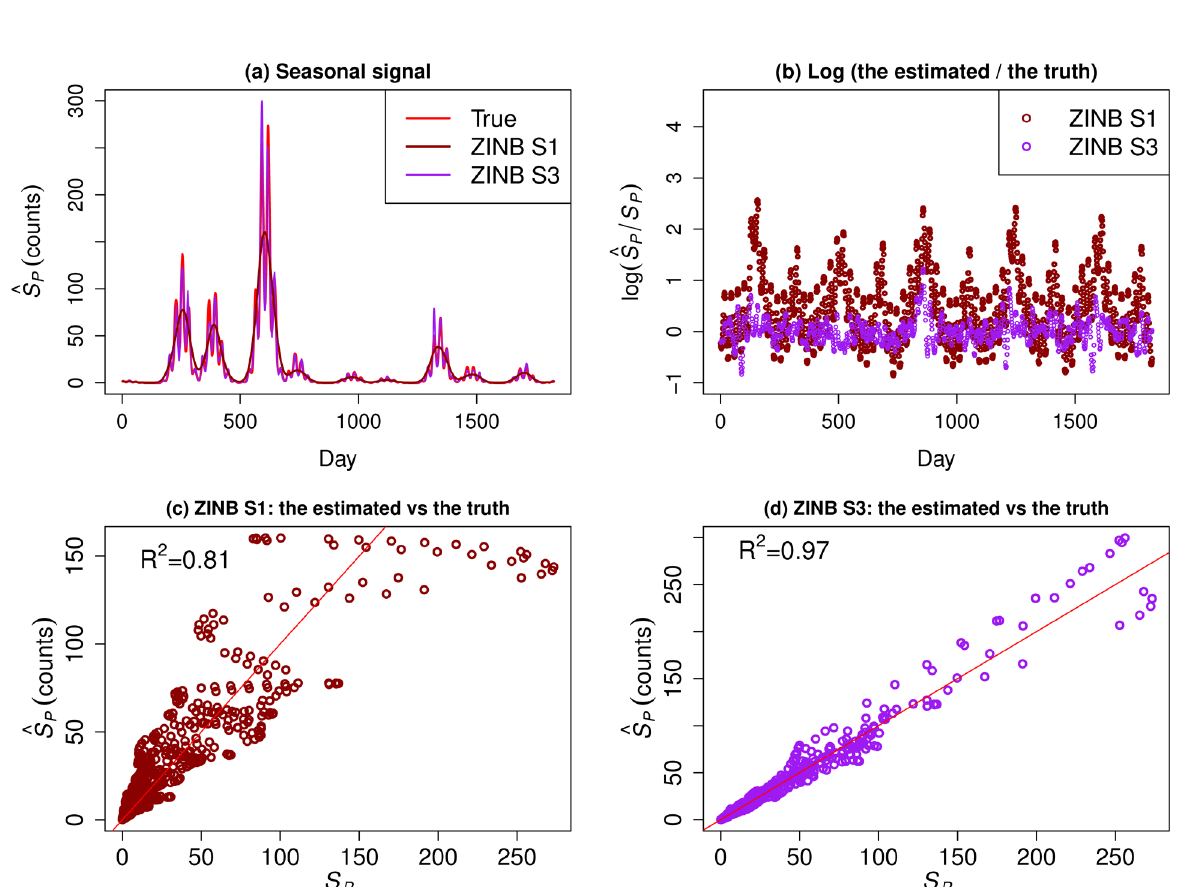
Figure 1. Simulation study: ( a ) The estimates of seasonal signal ( Ŝ ) for pseudo-dataset D3 reconstructed using the best-fitted model, i.e. P the zero-inflated negative binomial model. Smoothing technique S1 (a Gaussian kernel was used to smooth the counts prior to model fitting) produced the worst fit while smoothing technique S3 (a second-order random walk prior distribution imposed on temporal random effects) produced the best fit. ( b ) The scatter plot shows log( Ŝ / S ): ZINB S3 resulted in a much better fit of Ŝ than ZINB S1. ( c ) The ZINB S1 model P P P produced the worst fit when Ŝ (estimated) is fitted against S (the truth) on a simple linear regression; coefficient of determination, R 2 , is P P around 80%. ( d ) The ZINB S3 model produced the best fit when Ŝ is fitted against S on a simple linear regression; R 2 is close to 1. P P